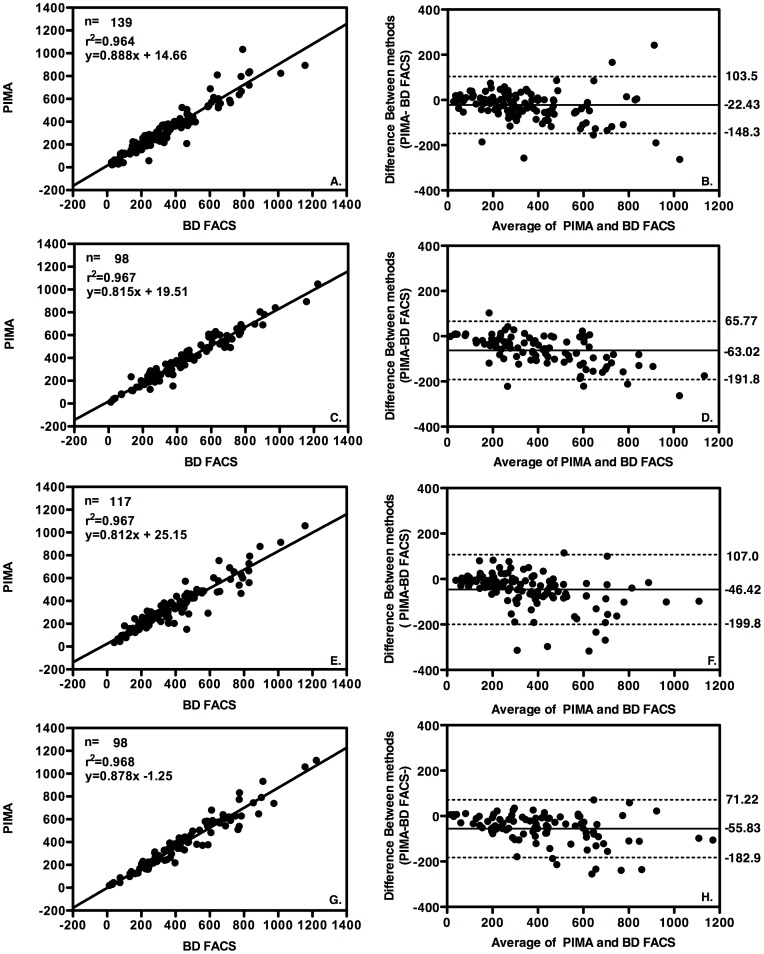
Accuracy of PIMA compared to BD FACS.Linear regression analysis plots (right column) and Bland Altman bias plots (left column) with upper and lower 95% limits of agreement (LOA) shown as broken lines and mean bias shown as an unbroken line. A. and B. PIMA versus BD FACS both performed at an urban (reference) laboratory, by a single laboratory technician, C. and D. BD FACS versus PIMA both performed at the rural laboratory by a single laboratory technician, E. and F. BD FACS performed by laboratory technician at an urban laboratory PIMA versus PIMA performed by clinical staff at an urban clinic, G. and PIMA. BD FACS performed at by laboratory technician at a rural laboratory versus PIMA performed at two rural clinics by clinical staff.